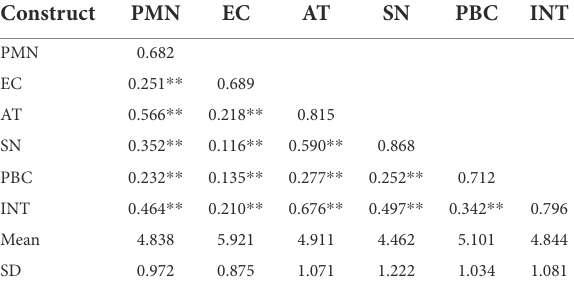
TABLE 1 Summary of descriptive statistics.